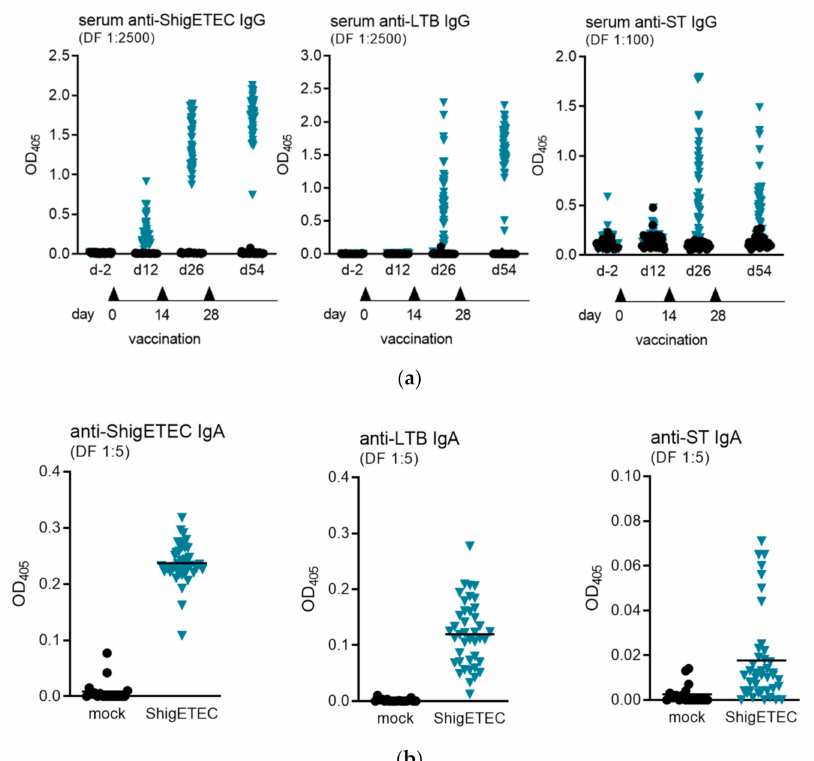
Figure 5. Detection of serum IgG and mucosal IgA antibodies induced upon ShigETEC vaccination. ( a ) Mice were vaccinated 3 times i.n. with 10 8 CFU ShigETEC. Specific IgG antibody levels were evaluated against indicated antigens in serum obtained 4 weeks after the last vaccination using the indicated serum dilutions in ELISA. Symbols represent averages of duplicate measurements of sera from individual mice (43 mice per group) from three independent vaccination experiments. ( b ) Mice were vaccinated 3 times i.n. with 10 8 CFU ShigETEC and challenged with lethal doses of either S. sonnei or S. flexneri 6 four weeks after the last vaccination. Bronchoalveolar lavages (BAL) were taken two weeks after the challenge. Specific IgA antibody levels were evaluated against the indicated antigens using the indicated serum dilutions in ELISA. Symbols represent averages of duplicate measurement of BAL samples from individual mice from three independent vaccination experiments with 18 and 41 mice per group for mock and ShigETEC,